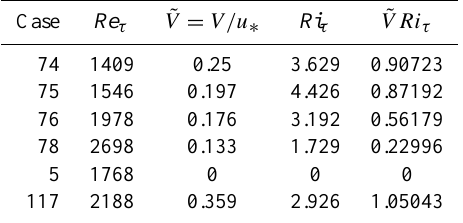
Table 3. List of all the experiments of Ismail (1952) used in the present study.